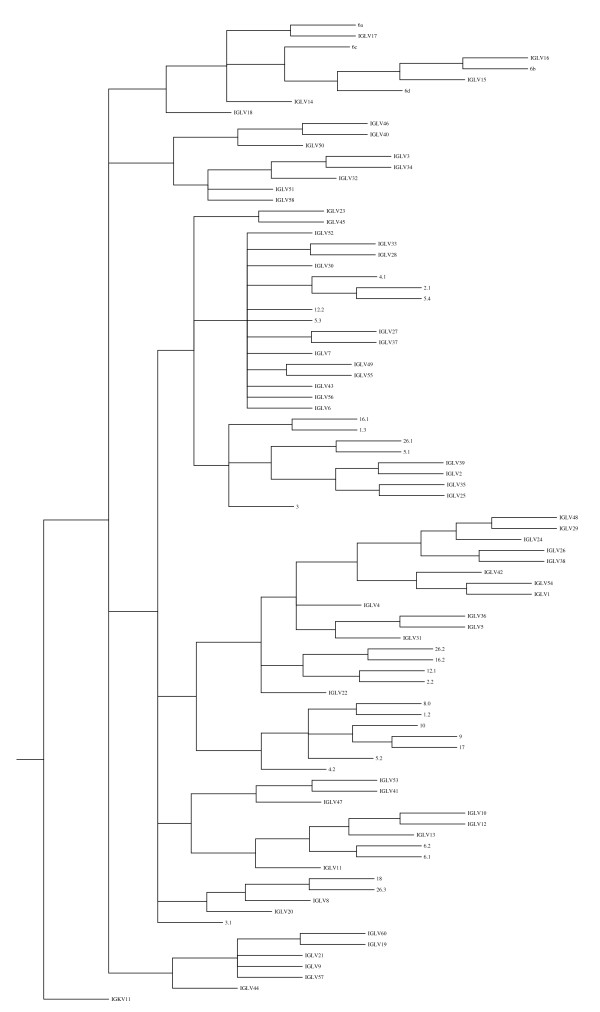
Phenogram of ruminant immunoglobulin λ variable genes. Sequences corresponding to the V region but excluding CRD3 were aligned and phylogenetically analyzed as described in the methods. IGKV11 was used as an outgroup. Ovine genomic sequences 1.2, 1.3, 2.1, 2.2, 3, 3.1, 4.1, 4.2, 5.1, 5.2, 5.3, 5.4, 6.1, 6.2, 8.0, 9, 10, 12.1, 12.2, 16.1, 16.2, 17, 18, 26.1, 26.2, 26.3 (AF040900–AF040924, M60441) are from Reynaud et al. [13] Ovine sequences 6a, 6b, 6c and 6d (AF038145–AF038148) are derived from cDNA [14].